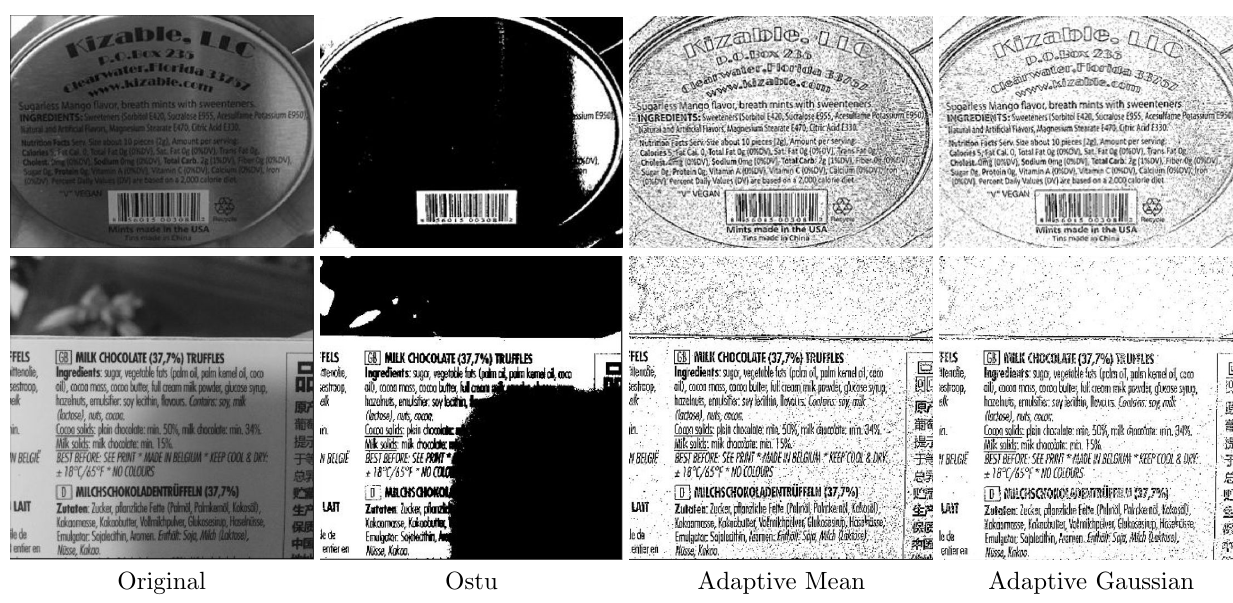
Figure 6. Comparison of different thresholding methods.